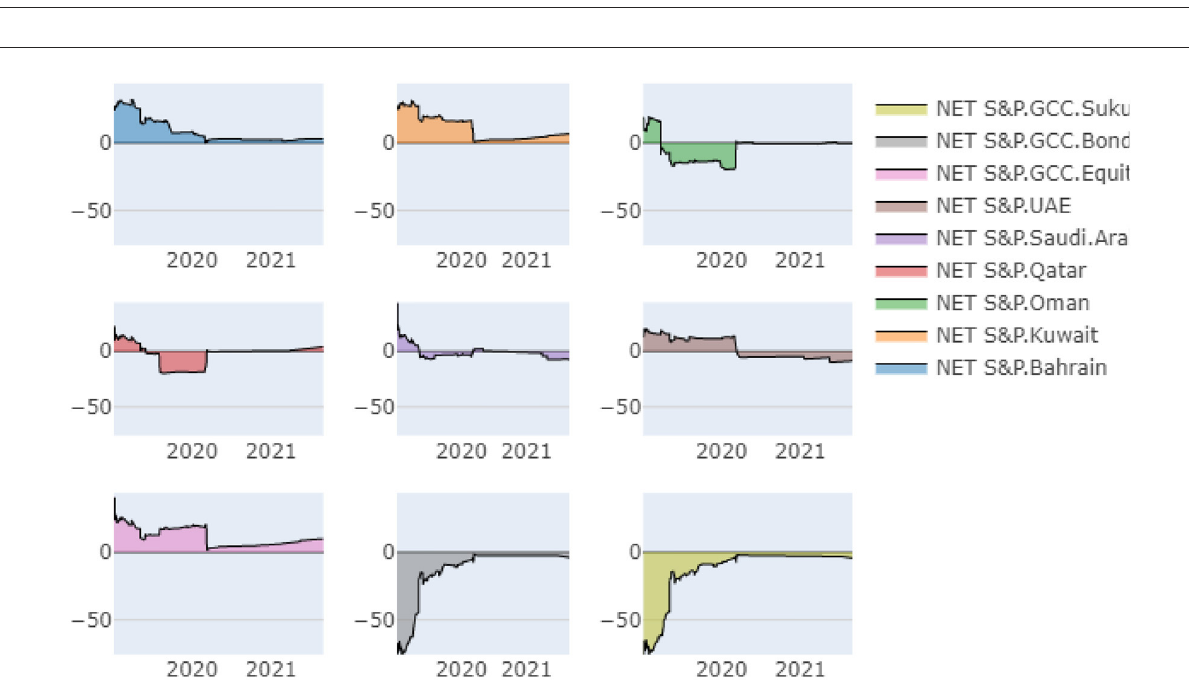
FIGURE4 Dynamic net total directional connectedness. The of TVP-VAR approach with lag-length of order one by (BIC) criterion and a 20-step-ahead generalized forecast error variance decomposition (FEVD) are provided in this figure. The colored area represents the net total directional connectedness, and its positive values indicates the net transmitter role and negative values indicate the net receiving role of financial market